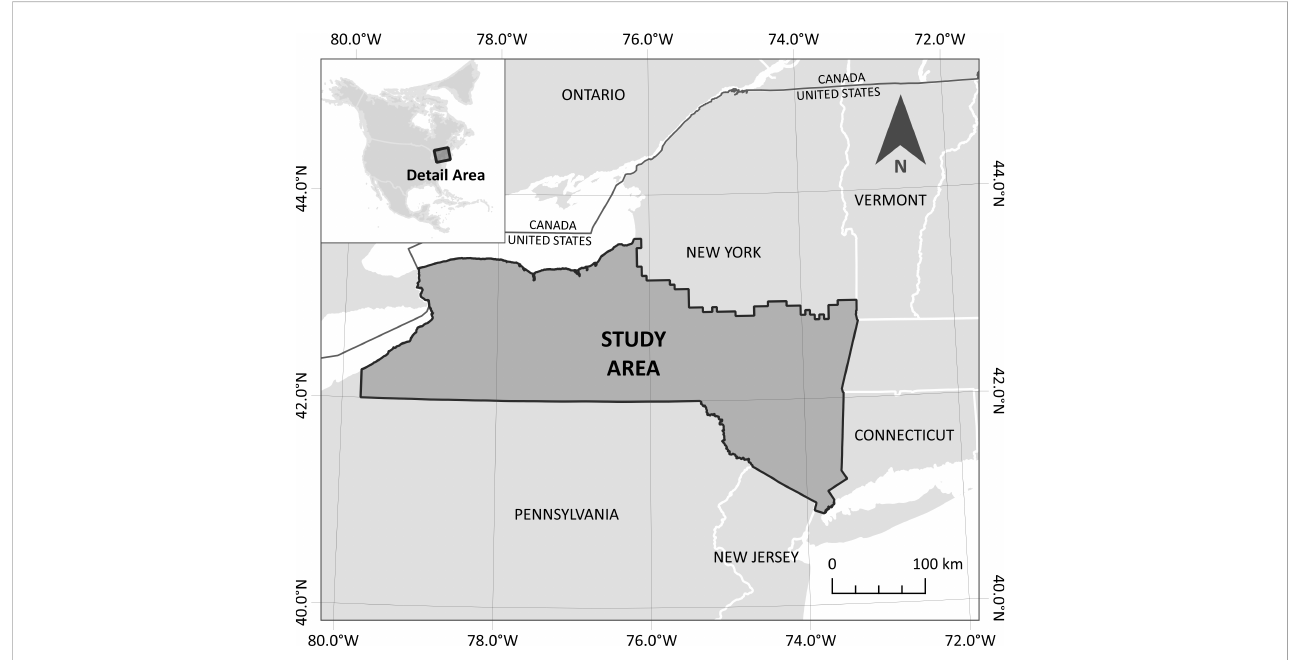
FIGURE 2 Study area where we tested a conceptual model of the ecological, social, and psychological variables that in fl uence acceptance capacity for black bears ( Ursus americanus) in New York State, USA. Dark line delineates the study area